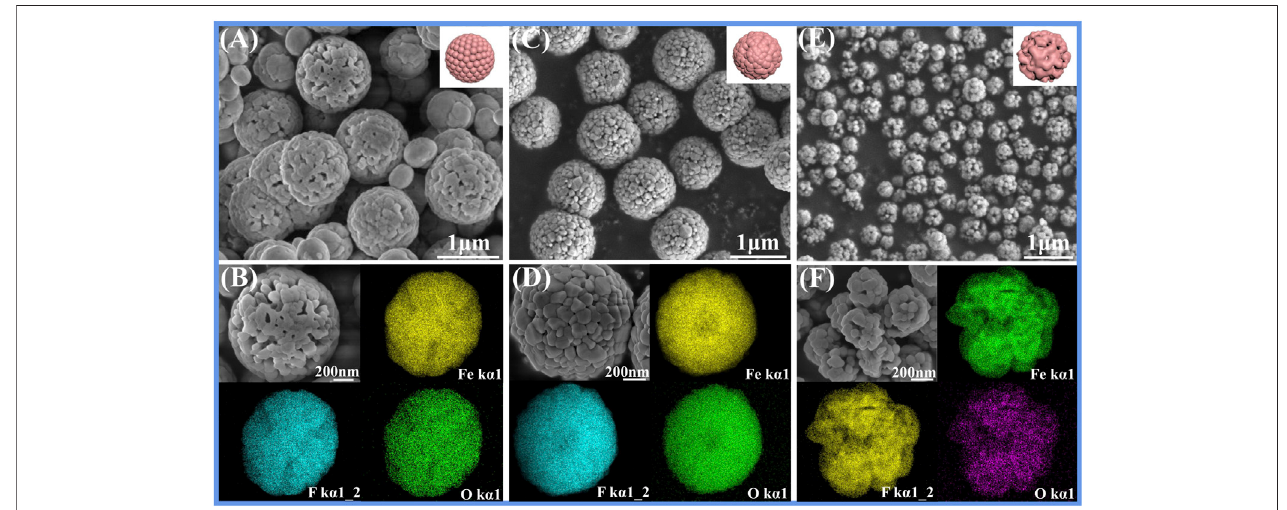
FIGURE 1 | SEM photographs of FeF 3 · 0.33H 2 O: (A,B) P-0, (C,D) P-10, (E,F) P-20, and the corresponding mapping images.